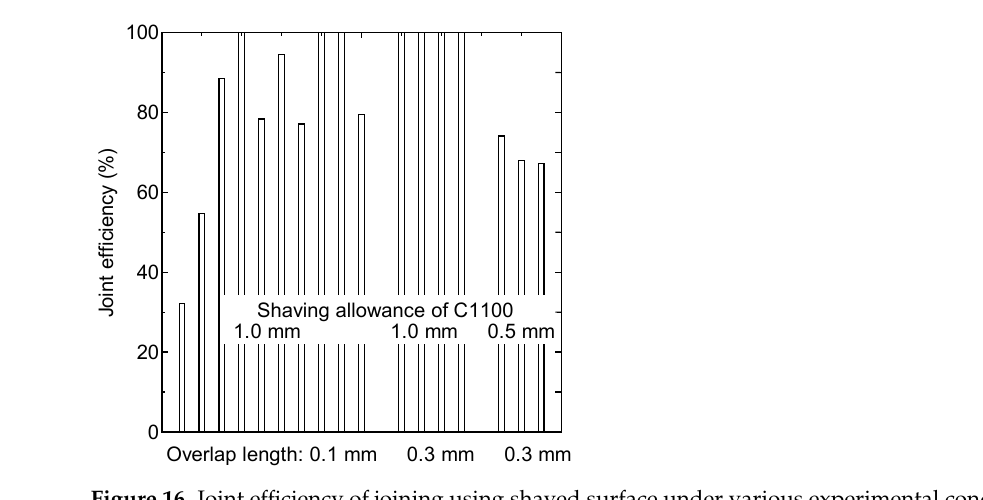
10 of 14 Figure 14. Cross-section of joint boundary using shaved surface: ( a ) Shaving allowance: C1100 1.0 mm, A6061 0.9 mm, overlap length: 0.1 mm; ( b ) Shaving allowance: C1100 1.0 mm, A6061 0.7 mm, overlap length: 0.3 mm. Figure 15. Tensile test specimen joined using shaved surface: ( a ) Schematic; ( b ) Photograph. Figure 16 shows the joint efficiency for the three experimental conditions. The shav- ing allowance of A6061 is smaller than that of C1100 by the overlap length, as mentioned